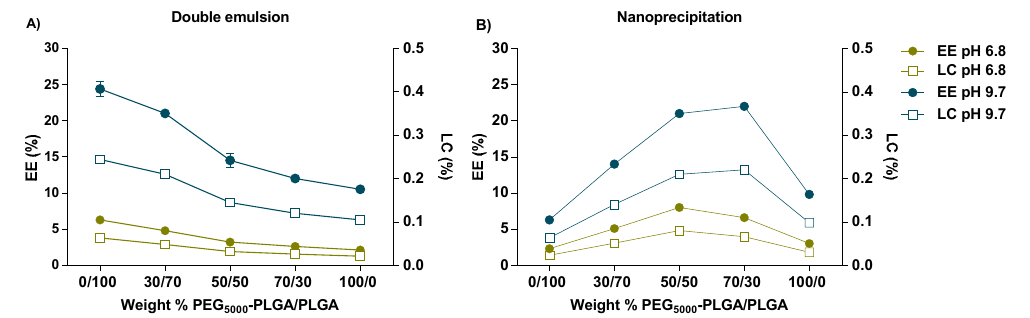
Figure 5. Encapsulation efficiency (EE%) and loading capacity (LC%) of FS10-loaded nanoparticles